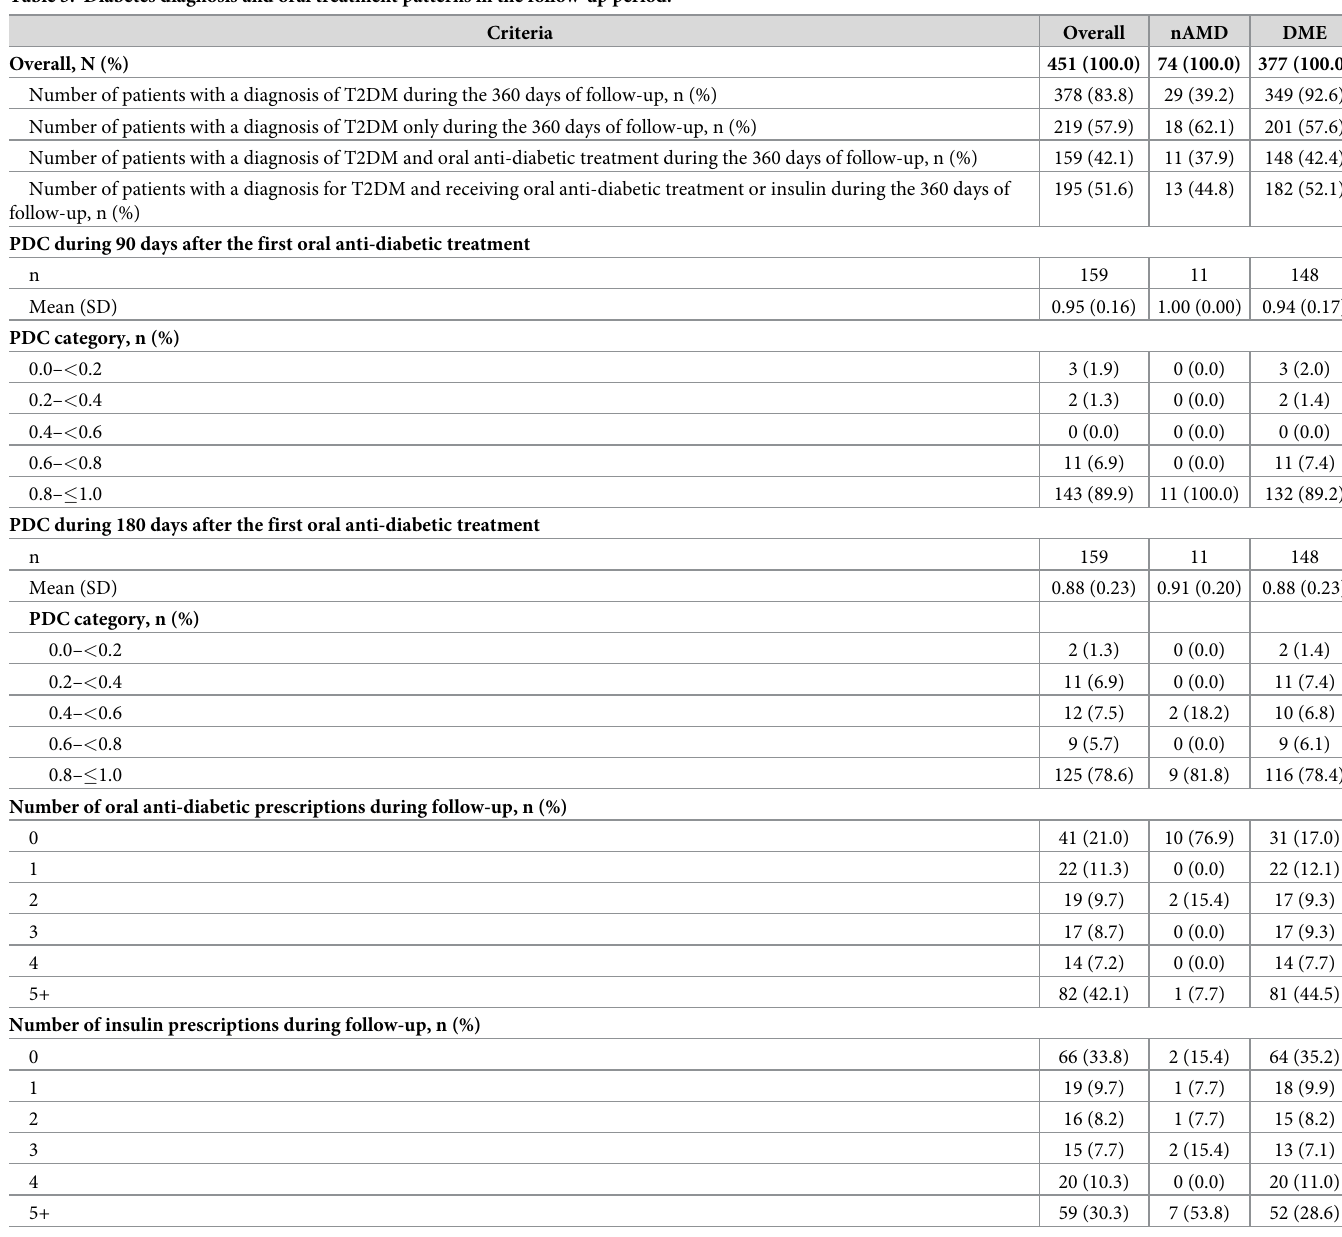
Table 5. Diabetes diagnosis and oral treatment patterns in the follow-up period.